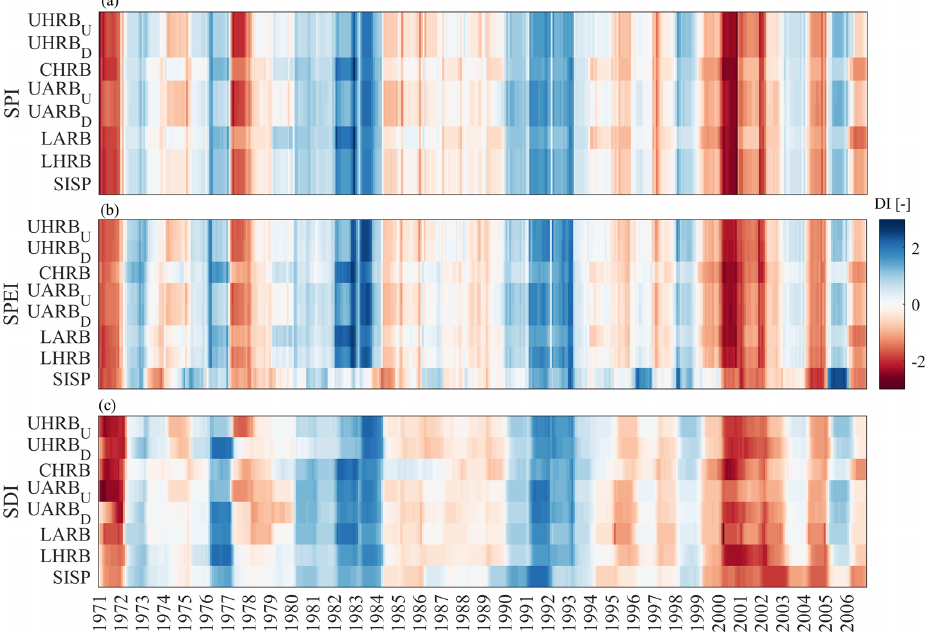
Figure 6. Time series of monthly drought indices (based on 12 months of accumulation time) SPI, SPEI, and SDI for the sub-basins ID1–ID8 for the 1970–2006 study period.